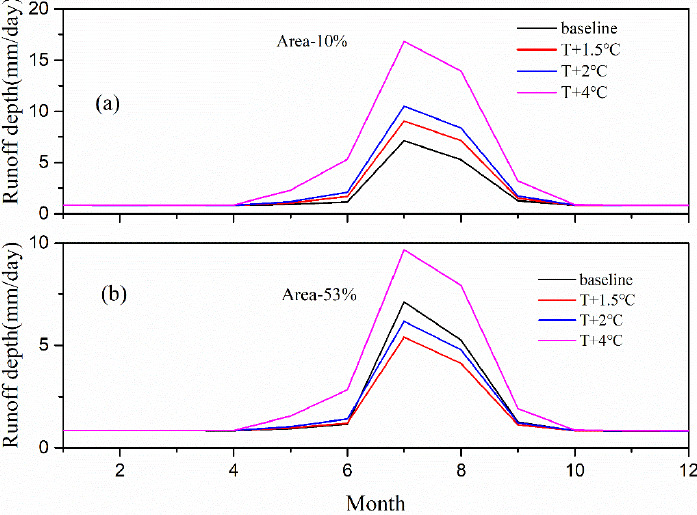
Figure 15. Sensitivity of runoff depth under different glacier area variations and temperature changes (1959–1961). ( a ) Glacier area decreased by 10 % ( b ) Glacier area decreased by 53 %